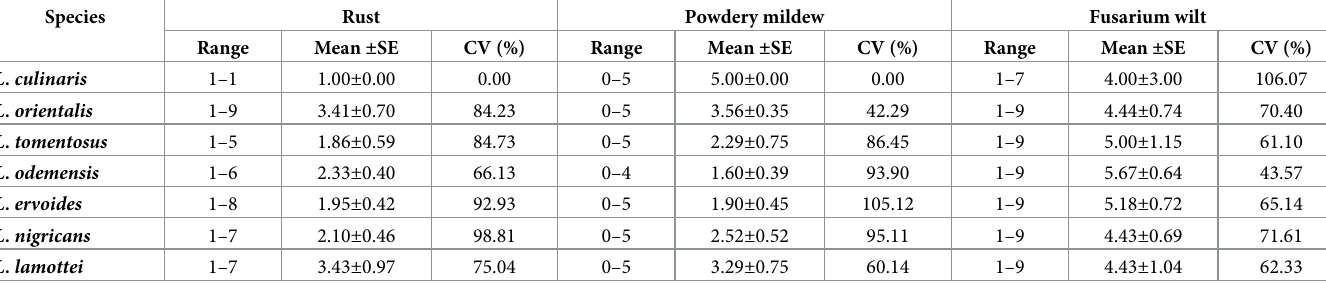
Table 4. Range of variation of wild lentil accessions against rust, powdery mildew and Fusarium wilt. Species